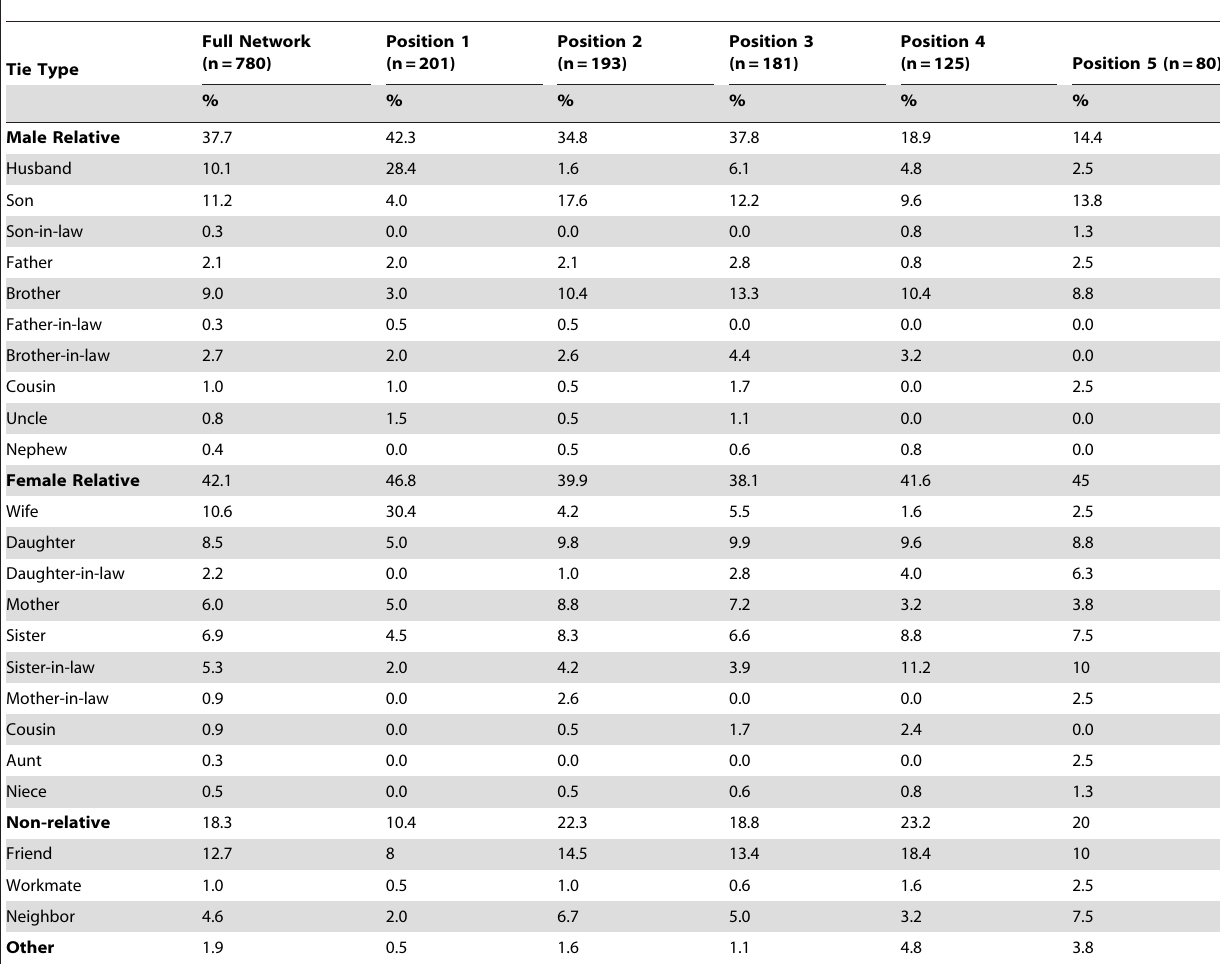
Table 5. Composition of ego-nominated networks by proportion of tie type among all nominated